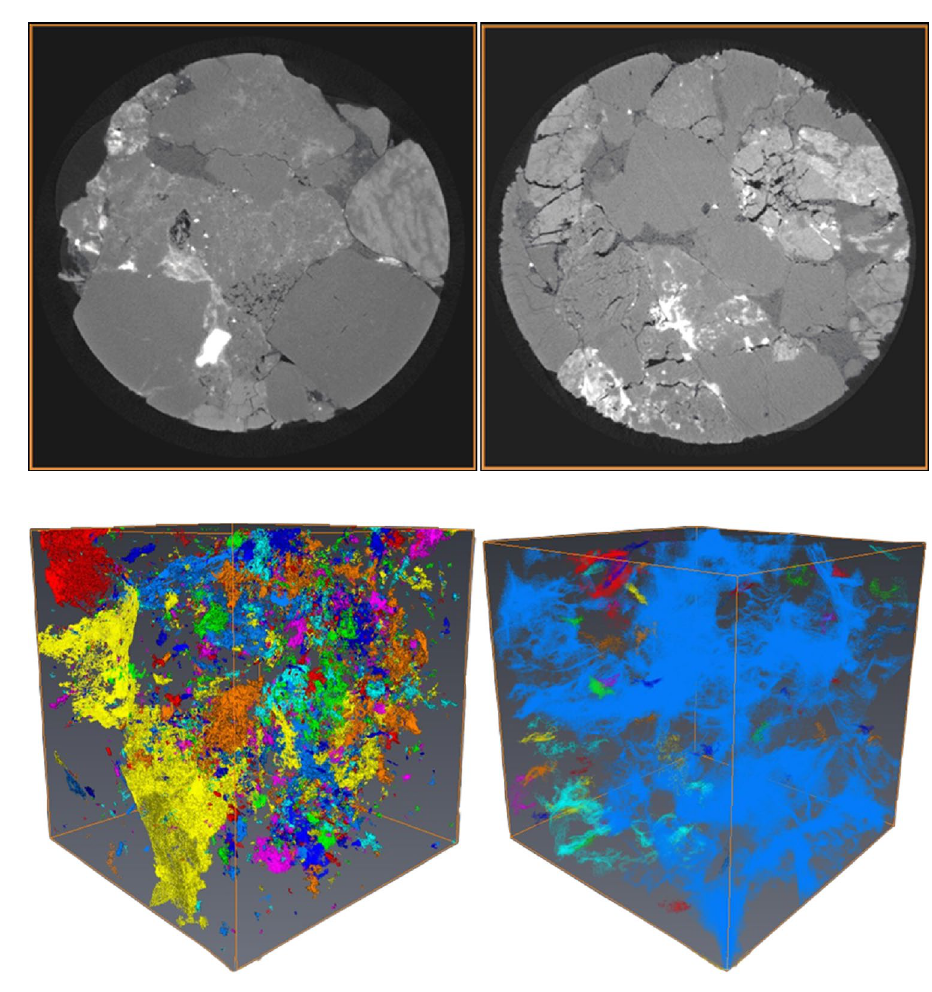
Fig. 4 2D section of 3D digital core of No.1 and No. 2 rock samples in Ybei X well